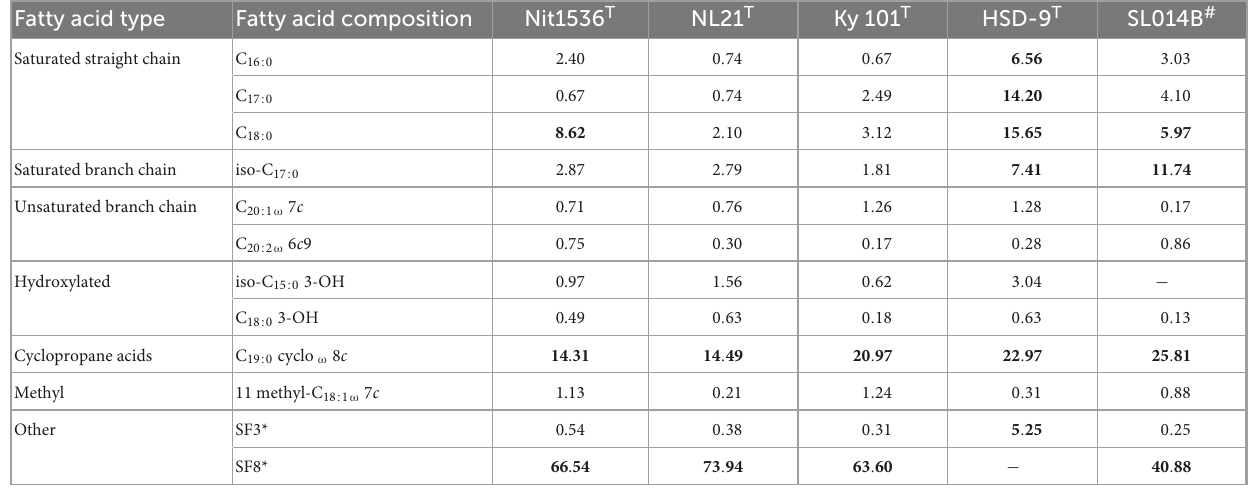
TABLE 2 Cellular fatty acid composition (%) of strain Nit1536 T and its closest related species Nitratireductor aquibiodomus NL21 T (DSM 15645, from marine denitrification system) (Labbé et al., 2004), N. kimnyeongensis Ky 101 T (DSM 19185, from dried seaweed) (Kang et al., 2009), Nitratireductor sp. HSD-9 T (DSM 19383, from beach sand) and Nitratireductor sp. SL014B-25A2 (DSM 22977 non-type strain, from oil-polluted